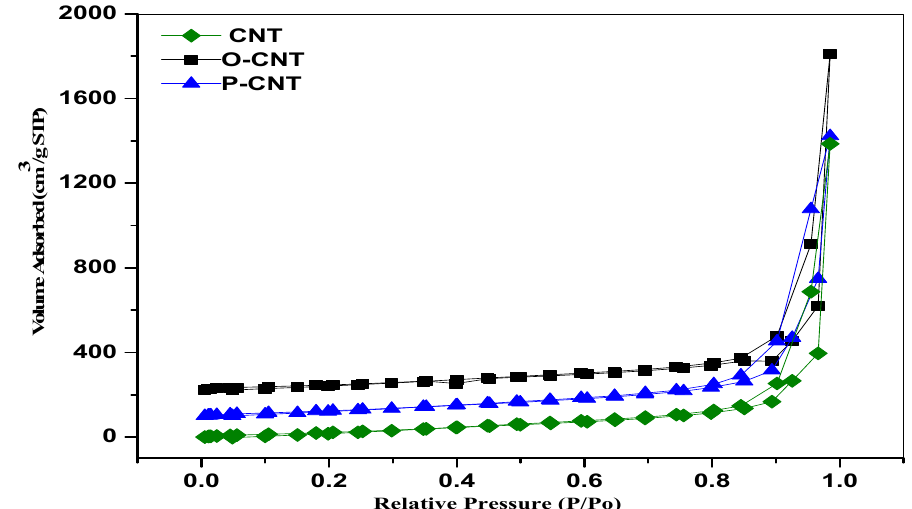
Figure 3. Nitrogen adsorption isotherms at 77 K for pristine (CNTs), oxidized (O-CNTs), and polymer functionalized (P-CNTs) nanotubes.